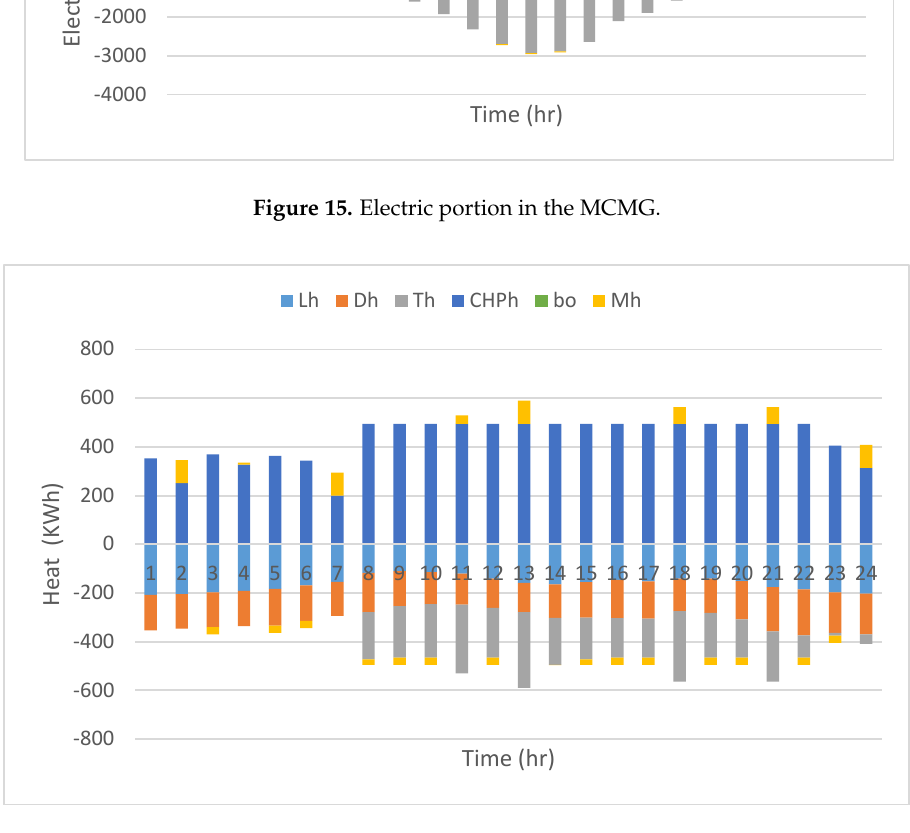
Figure 16. Heat portion in the MCMG.